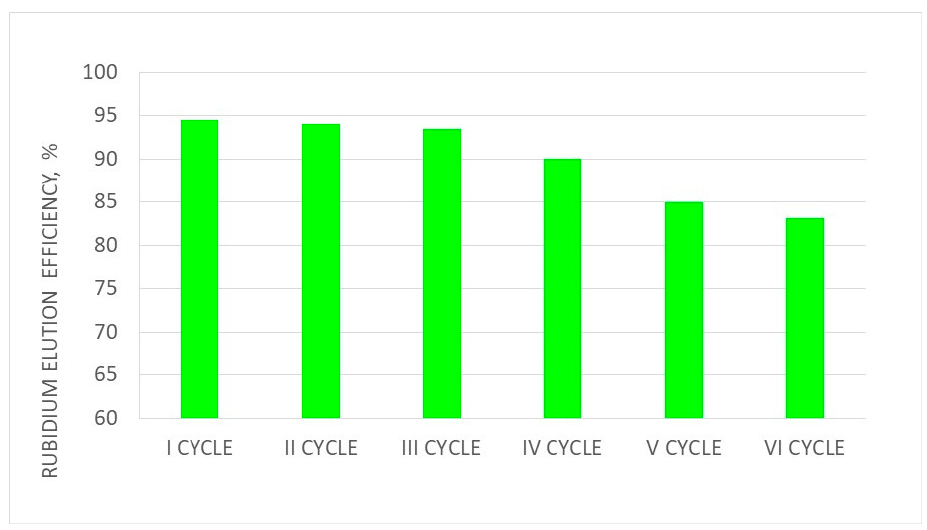
Figure 9. Changes in sorption efficiency in subsequent cycles (I–VI).